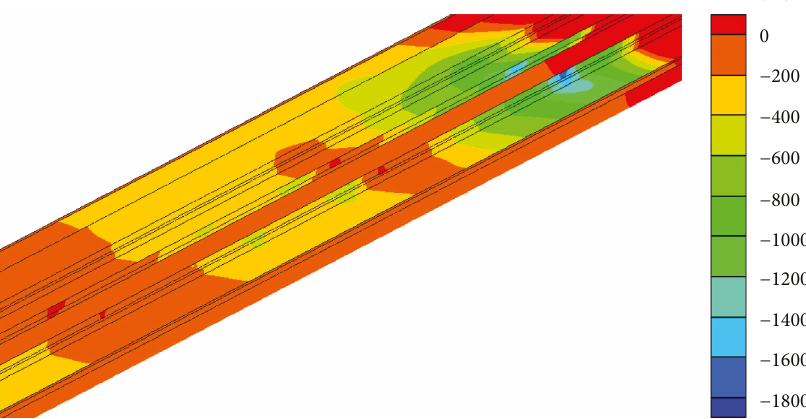
Figure 6: Contour of pressure distribution of high-speed railways on